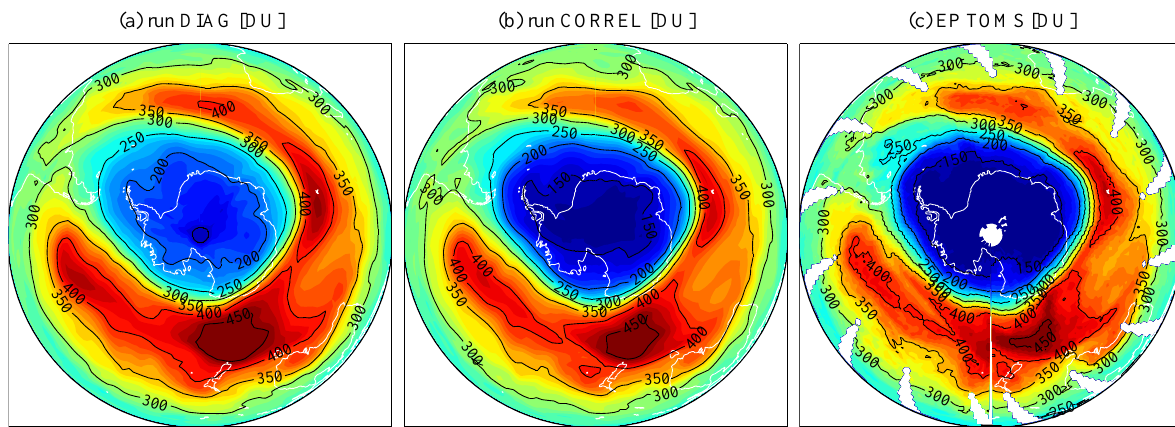
Fig. 6. Total ozone in the Southern Hemisphere on 1 October 2003 obtained by the runs DIAG (a) and CORREL (b) , and observed by the Total Ozone Measurement Satellite (TOMS) (c) , in Dobson unit